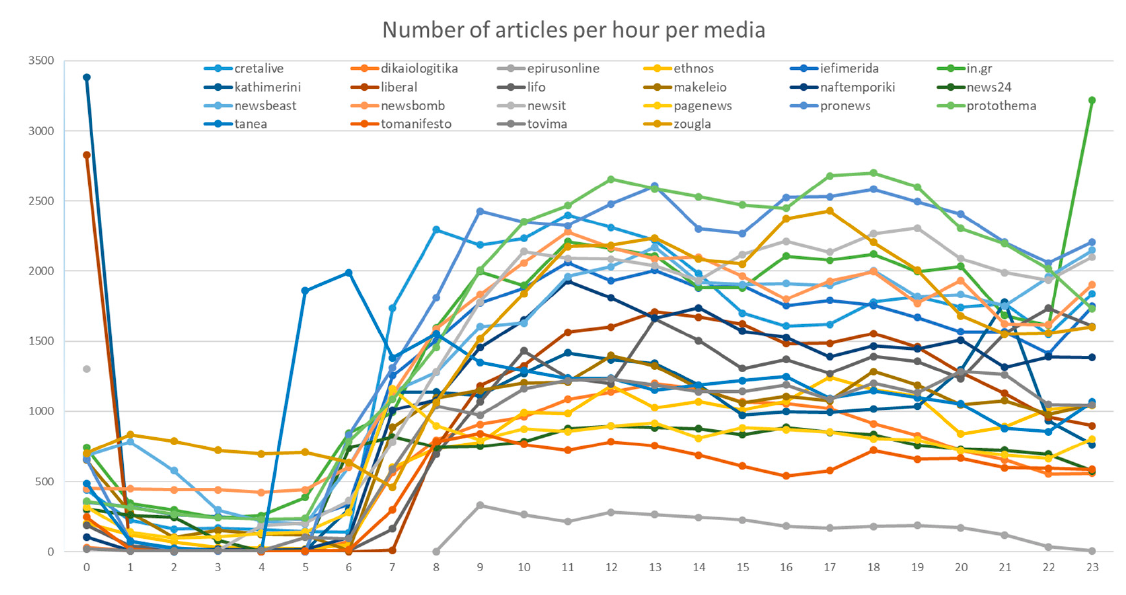
Figure 11. Number of articles per hour per media.